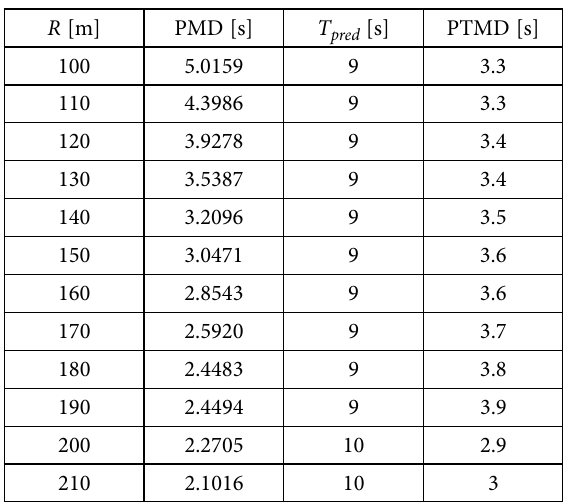
Fig. 4. Change in time T pred with speed ( vo represents the speed of the oncoming vehicle; vh represents the speed of the host vehicle)